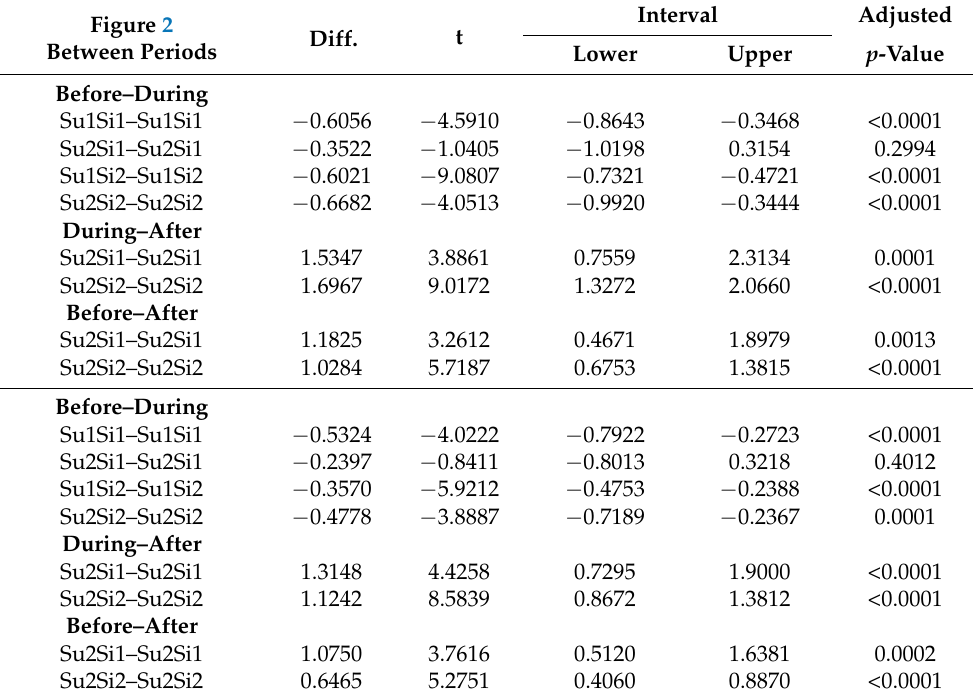
Table A1. Hypothesis tests of means corresponding to Figure 2. Women upper panel, men lower panel.